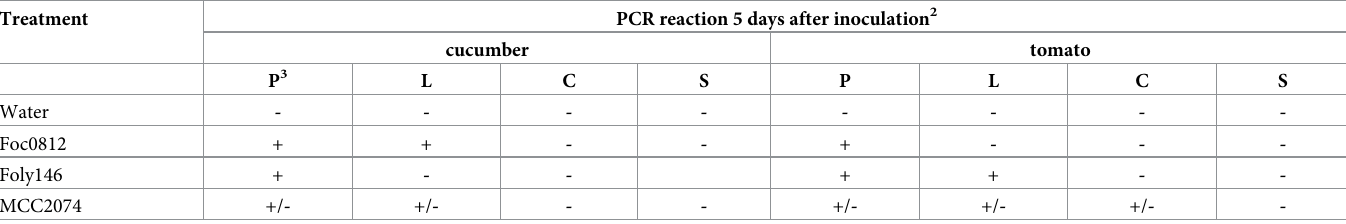
Table 5. Colonization of tomato and cucumber fruit by HOFo isolate MCC2074, F . oxysporum f. sp. lycopersici and f. sp. cucumerinum following surface inoculation 1 .